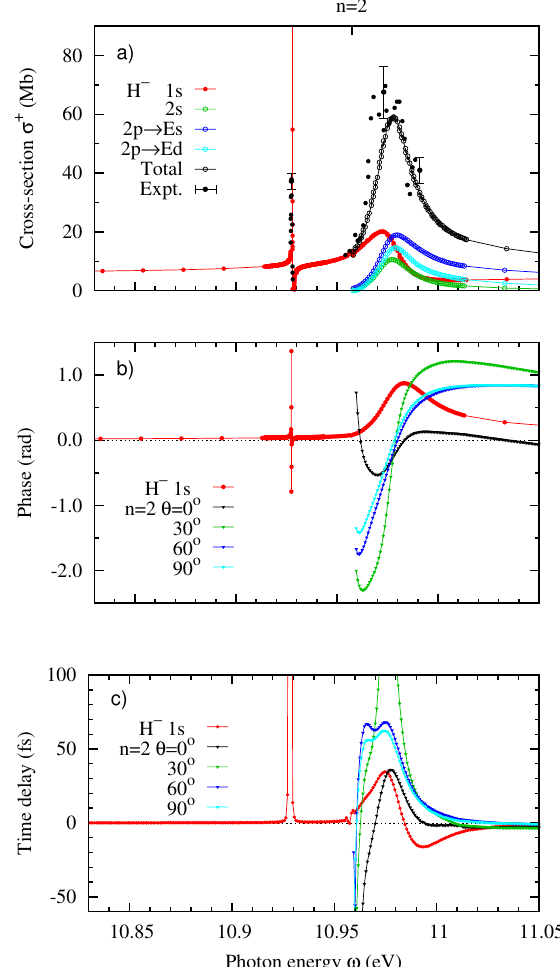
Figure 4. (Color online) ( a ) The cross section (8), ( b ) the phase of the transition amplitude, and ( c ) the time delay (9) of H − in various photodetachment channels near the n = 2 threshold. The experi- ment [50] is displayed in the top